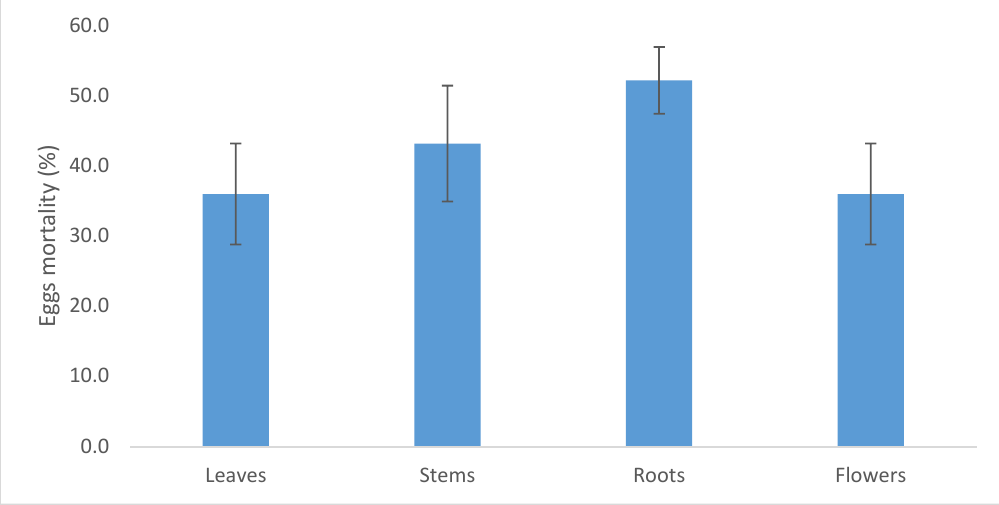
Figure 5. Mortality of eggs of Cadra Cautella treated with the C. procera methanolic extracts of leaves, branches, roots, and flowers. Bars represent standard error.